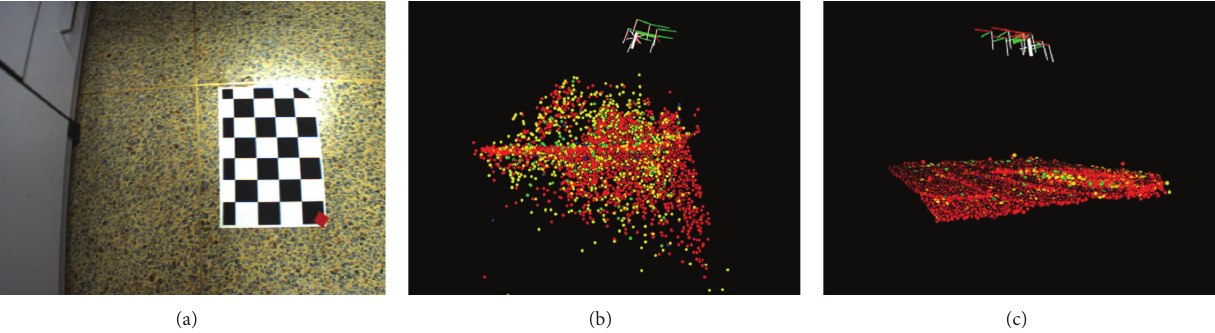
Figure 5: A compare result of the original PTAM and the improved PTAM algorithm: (a) is the experiment environment, (b) shows the map generated by the original PTAM, and (c) shows the map generated by the improved PTAM.